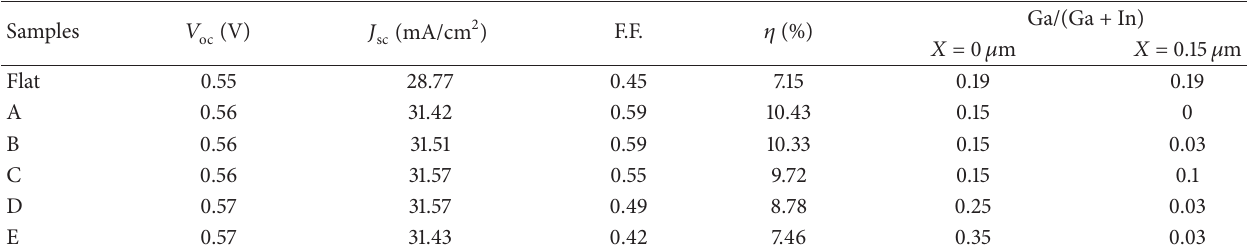
Table 2: Photovoltaic parameters of different sample of CIGS solar